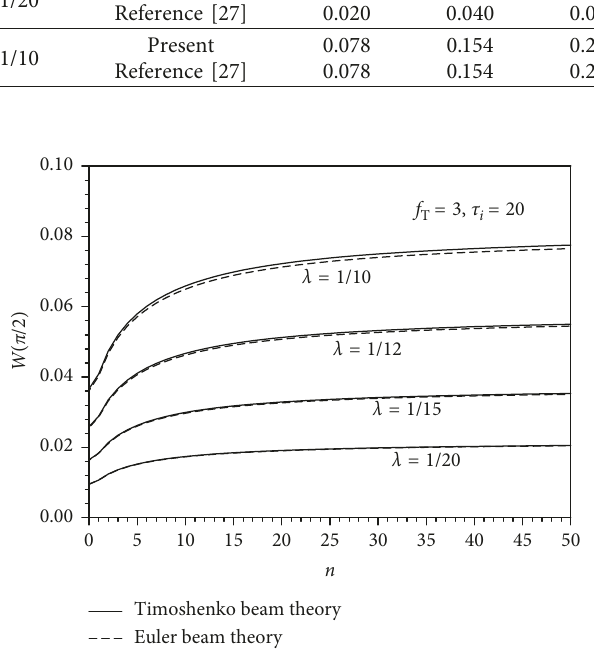
π /2 versus the power ( )